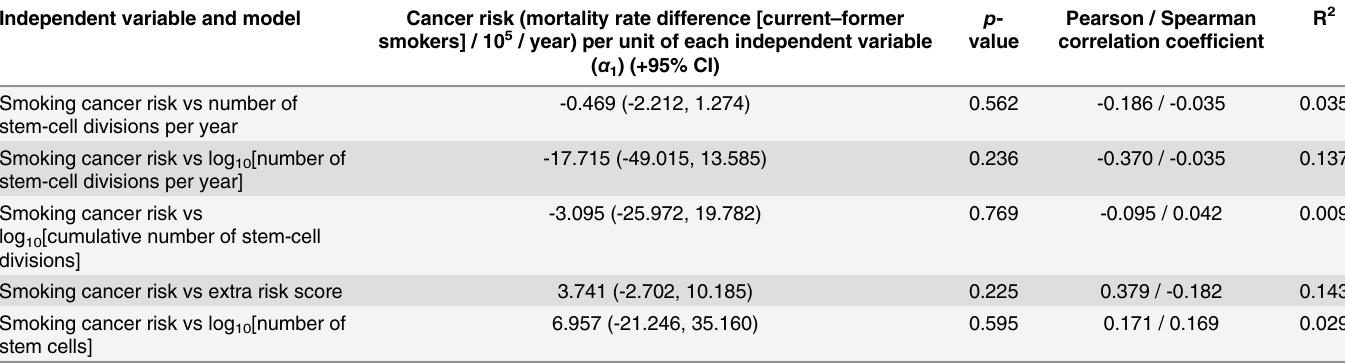
Table 5. Trends of linear regression model (12) fitted to mortality rate difference [current smokers – former smokers] (/10 5 /year) with explanatory variables (a) numbers of stem-cell divisions per year, (b) log 10 [cumulative number of stem-cell divisions], (c) extra risk score (ERS) and (d) log 10 [- number of stem-cells], using data of Tomasetti and Vogelstein [2], as in Table 2. Independent variable and